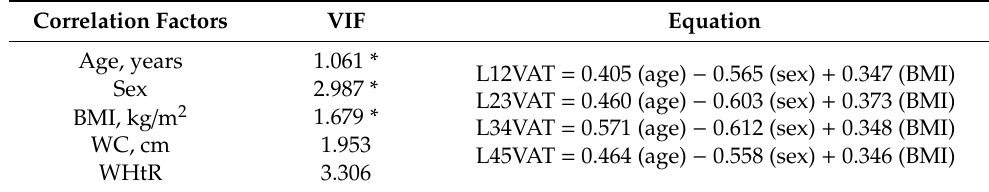
Table 6. Ethnicity-specific equations to estimate VAT depositions for NZ Europeans.